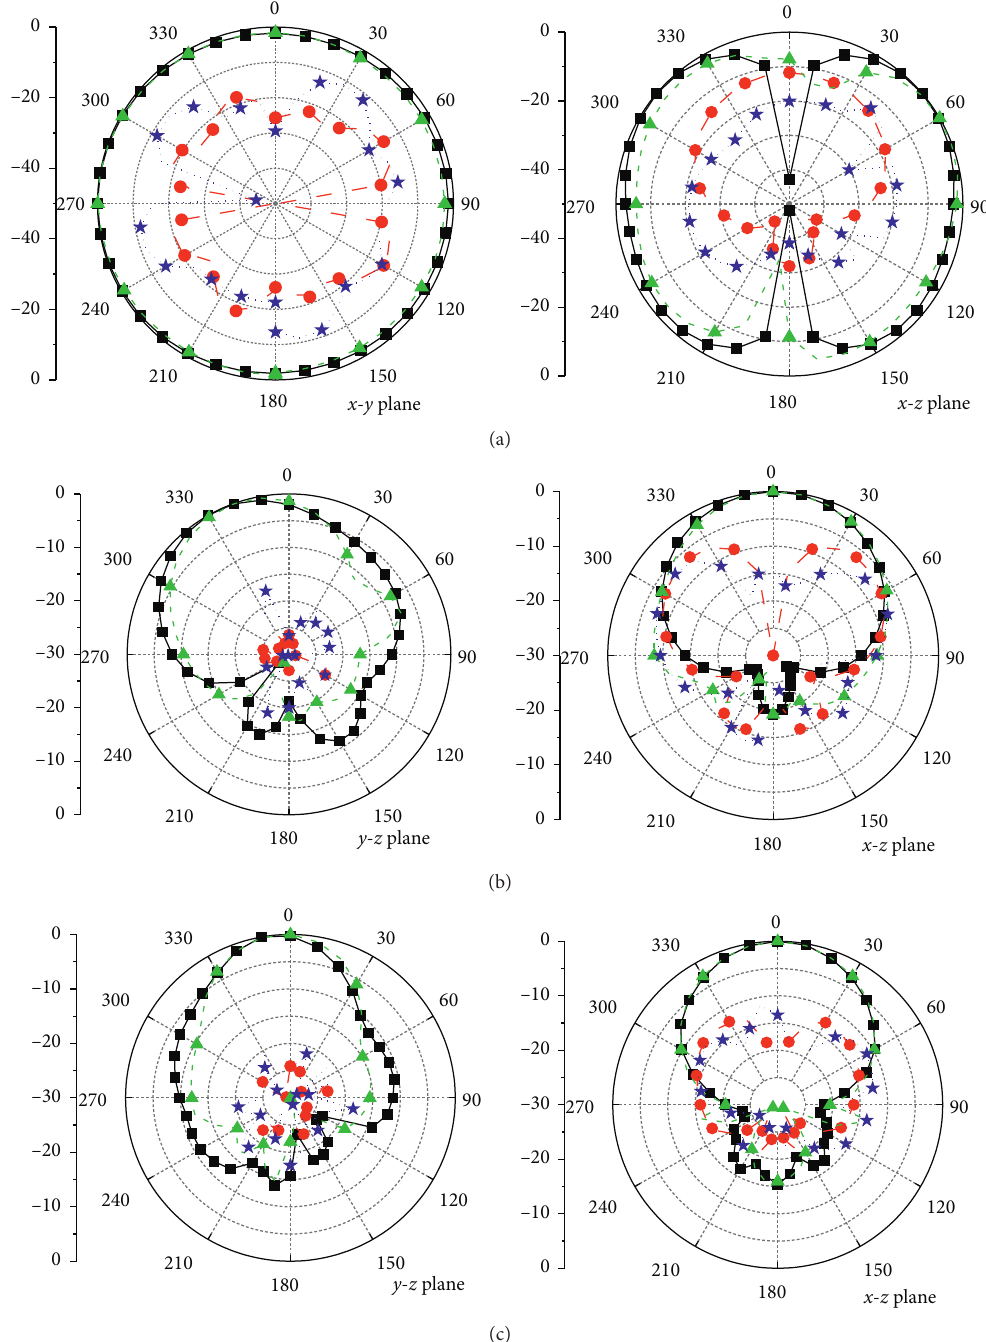
Figure 15: Simulated and measured radiation patterns of the proposed triband patch antenna at (a) 2.6GHz, (b) 3.6 GHz, and (c) 5.3